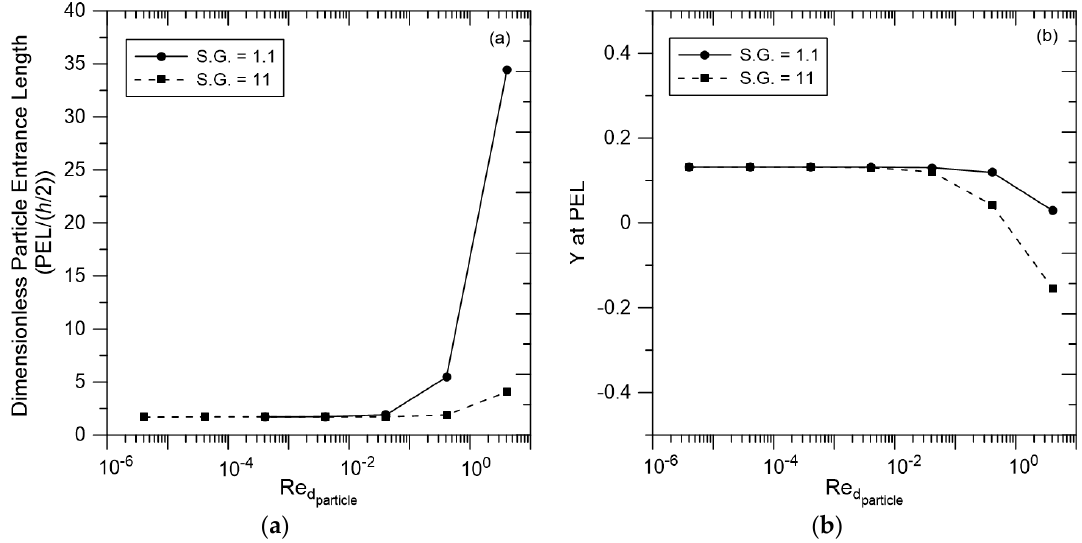
Figure 9. ( a ) PEL as a function of Re for particles with specific gravity = 1.1 and 11; ( b ) Y at PEL as particle d PEL as a function of Re d for these same particles. Results are presented for a system with λ = 0.1, for these same particles. Results are presented for a system with λ = 0.1, Y initial = 1, a function of Re particle particle d Y initial = 1, X initial = − 5 and r c /( h / 2 ) = X initial = − 5 and r c /(h/2) = 1.